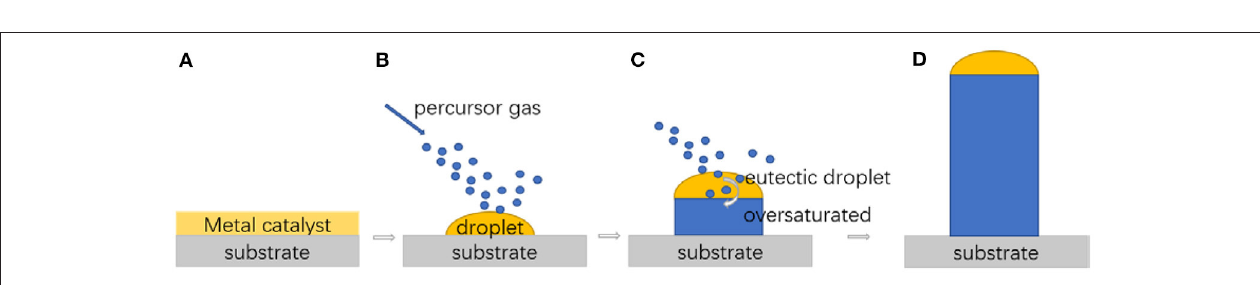
FIGURE 10 | (A–D) VLS growth mechanism. Reprint with permission from Chen R. et al. (2019). Copyright 2019 American Chemical